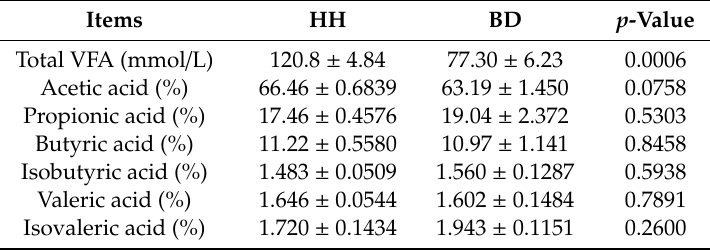
Table 2. Rumen volatile fatty acids (VFAs) of Holstein heifers.